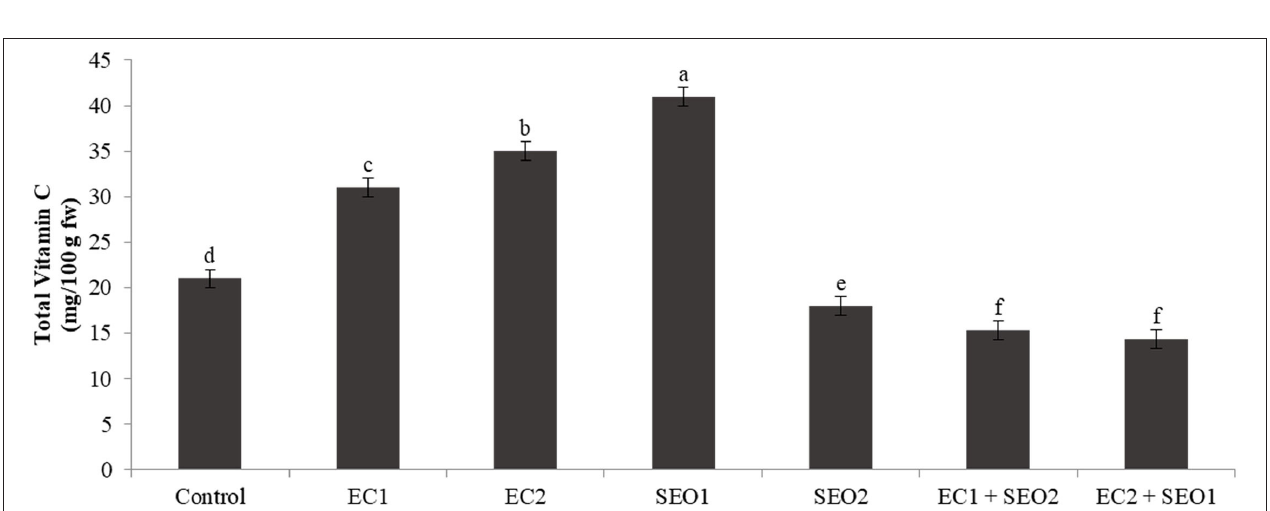
FIGURE 5 | Total vitamin C content (mg/kg fw) of tomato fruits under control (C, 0.4 dS/m), saline (EC1, 3.5 dS/m; EC2, 7 dS/m), spent engine oil stress (SEO1, 0.5%; SEO2, 1%) and the combinations (EC1/SEO2, 3.5 dS/m EC/1% SEO), (EC2/SEO1, 7 dS/m EC/0.5% SEO). Values are means ( n =